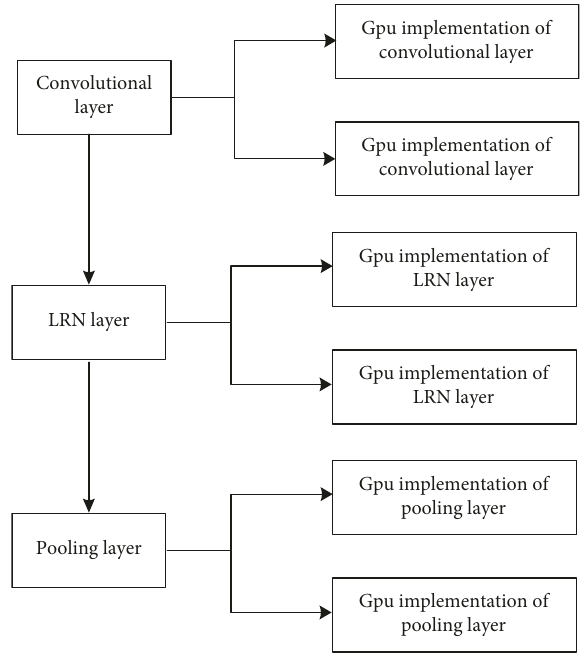
Figure 2: Schematic diagram of the visual layer module.